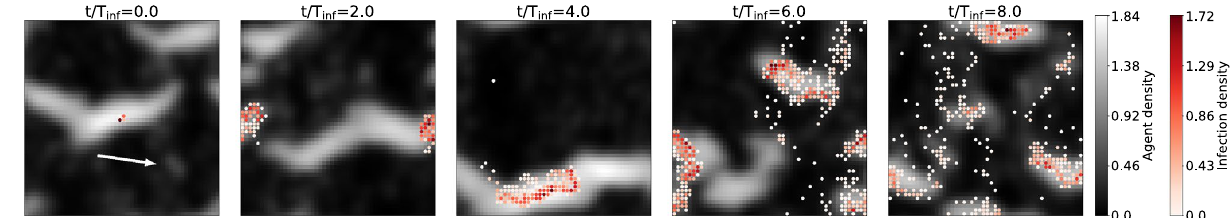
Figure 7. Infection dynamics in an ordered clustered state, visualized as in Fig. 4. The spatial dynamics corresponds to the ordered clustered state OC presented in Fig. 1, with (Pe,g) = (32,128), here advancing to the right as indicated by the white arrow. The panels display the temporal evolution of a single infection process 3 (with T inf = 10 and (cid:31) = 2 ) started by 10 agents within a cluster. We observe that the infection initially spreads within the cluster, slowly but robustly, and then reaches other clusters through their fission-fusion